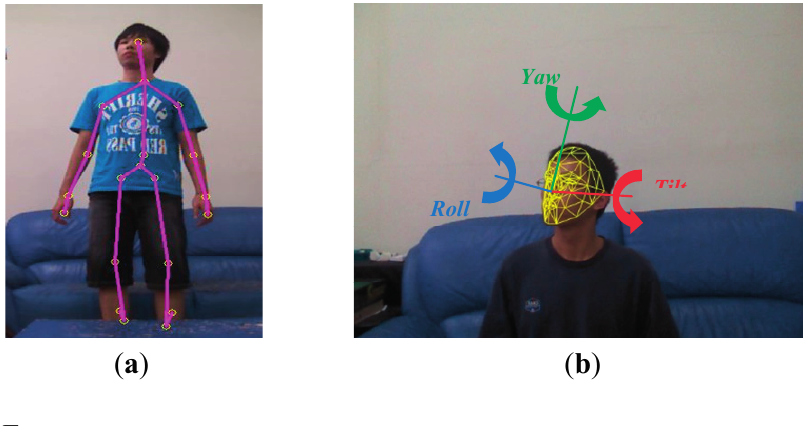
Figure 2. Human tracking using a Kinect. ( a ) Skeleton tracking; ( b ) Face